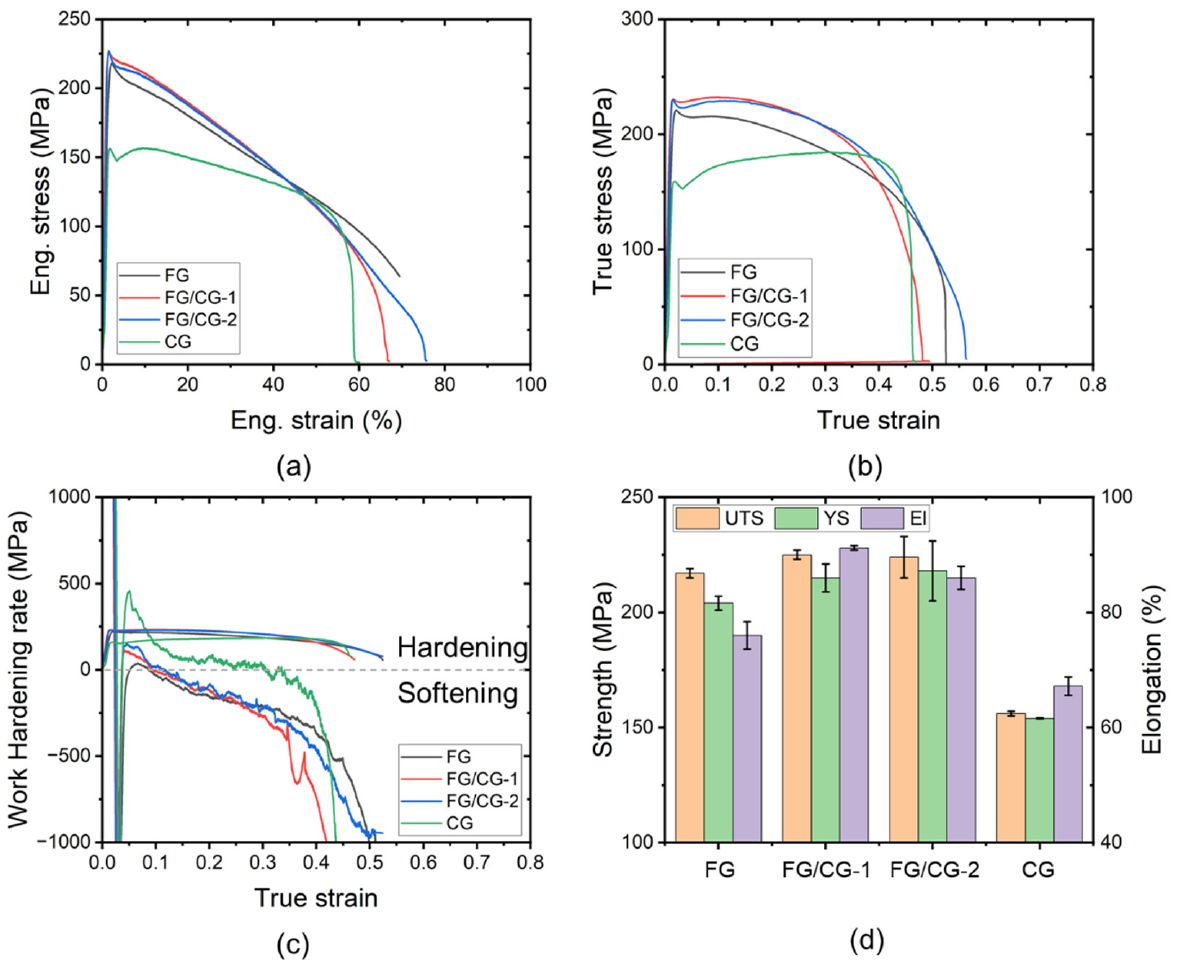
Figure 2. Tensile properties of the alloy samples tested at 900 °C: ( a ) engineering stress–strain curves, ( b ) true stress–strain curves, ( c ) work hardening rate, and ( d ) strength and elongation.